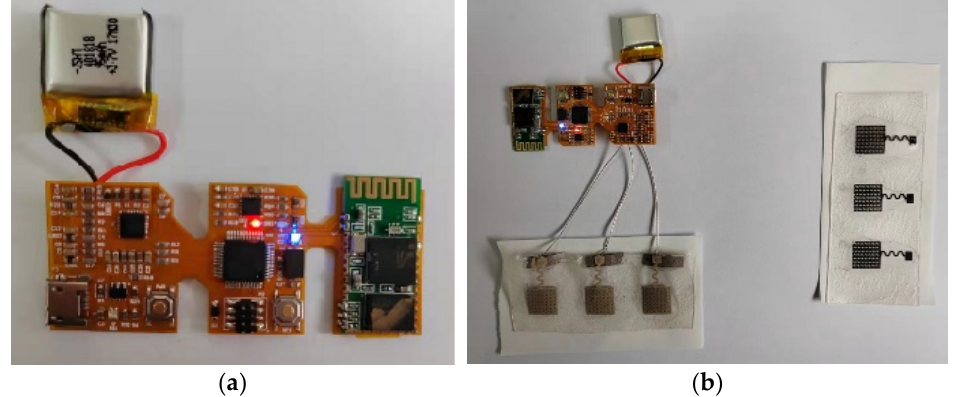
Figure 7. Flexible sEMG acquisition system. ( a ) Flexible circuit hardware; ( b ) hardware connected with single-lead sEMG sensor. with single-lead sEMG